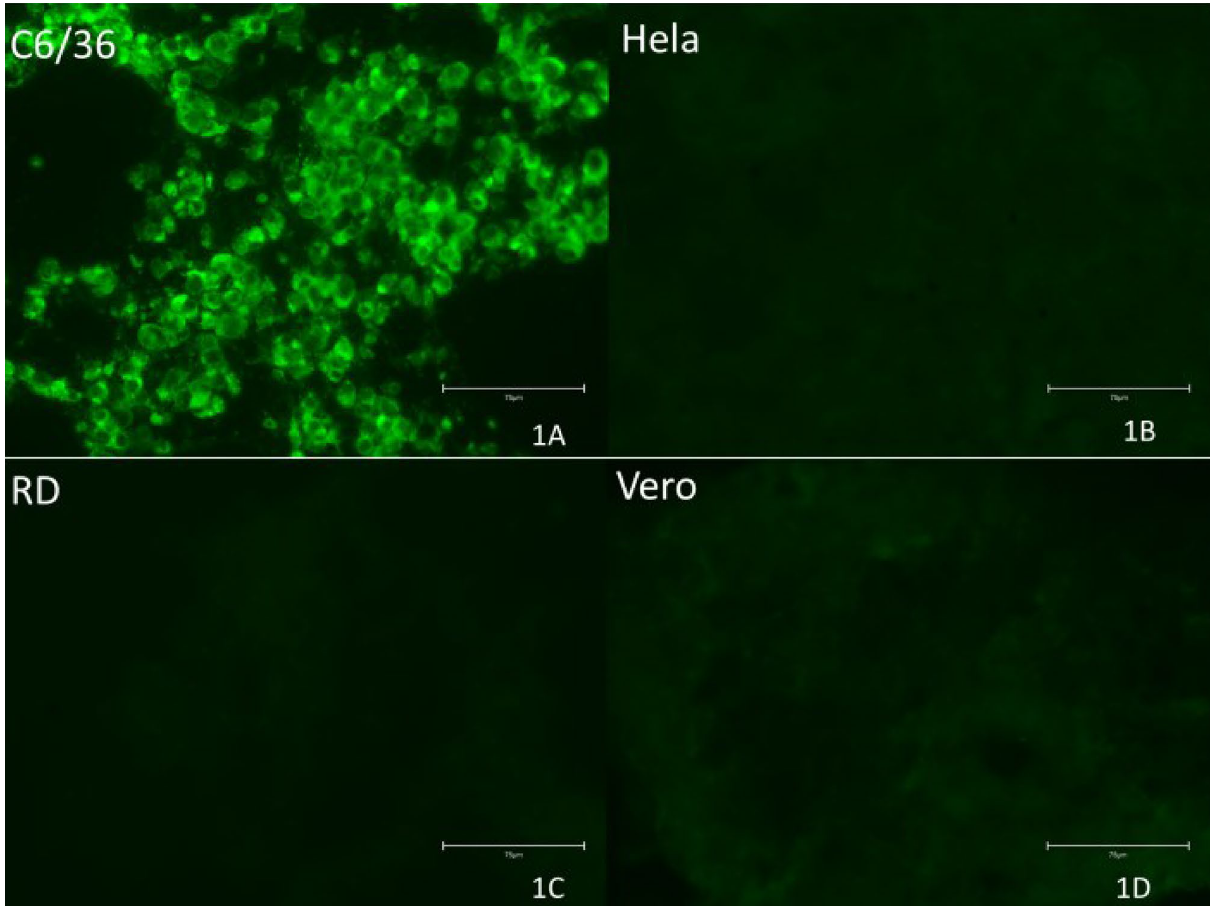
Figure 1. Guapiaçu virus IFA results on day 7 after inoculation. 1A: C6/36 infected cells; 1B: Hela cells; 1C: RD cells; 1D: Vero cells. Scale in 75μM